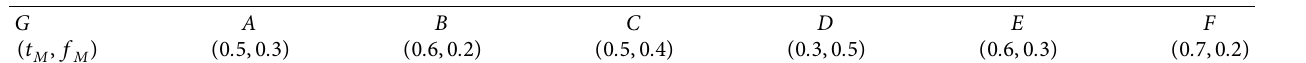
Table 3: Weight of nodes in G .